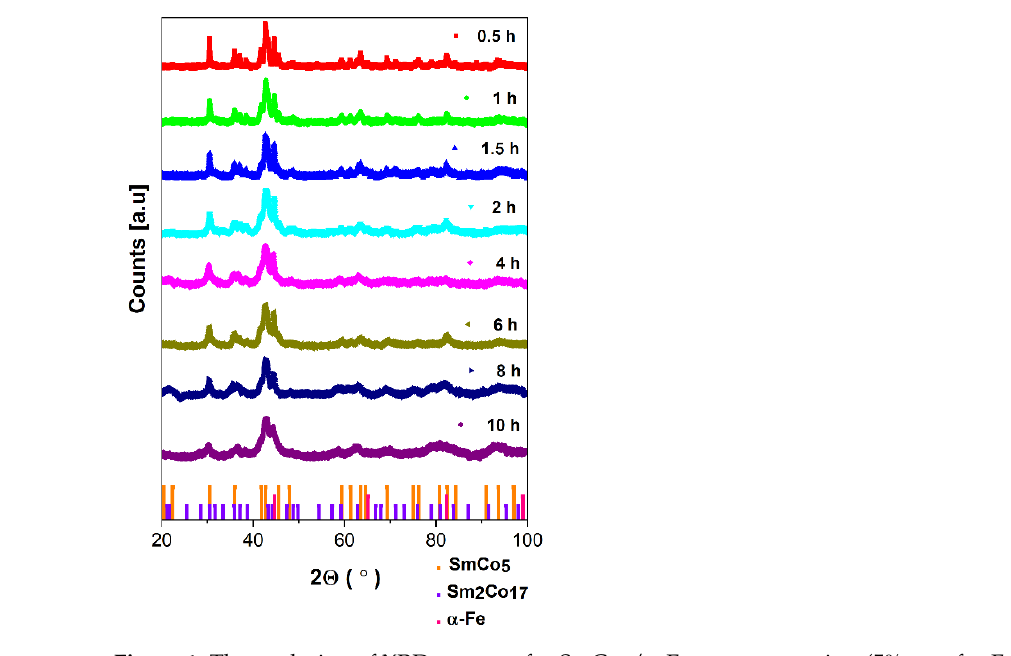
Figure 1. The evolution of XRD patterns for SmCo 5 /α-Fe nanocomposites (5%wt. of α-Fe) versus milling time. The detected crystal phases are denoted by bars: SmCo 5 —orange, Sm 2 Co 17 —violet, α-Fe—pink. Table 1. Crystal structure parameters determined from Rietveld refinement of XRD pattern for SmCo 5 / α -Fe (5%wt. of α -Fe).